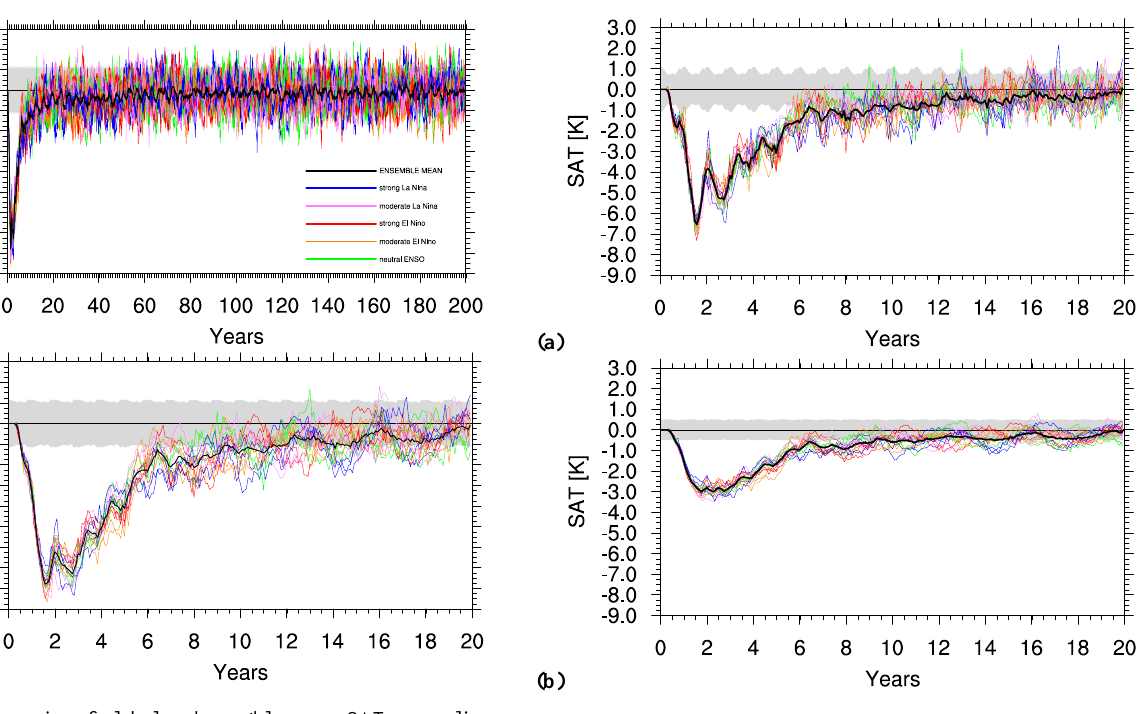
Fig. 3. Time series of global and monthly mean SAT anomalies over (a) land points only and (b) ocean points only for the first 20 years of the model integrations. The grey shaded area represents the monthly mean 2 σ -bar from the control experiment. Colours indicate the initial conditions of the integrations as in Fig.